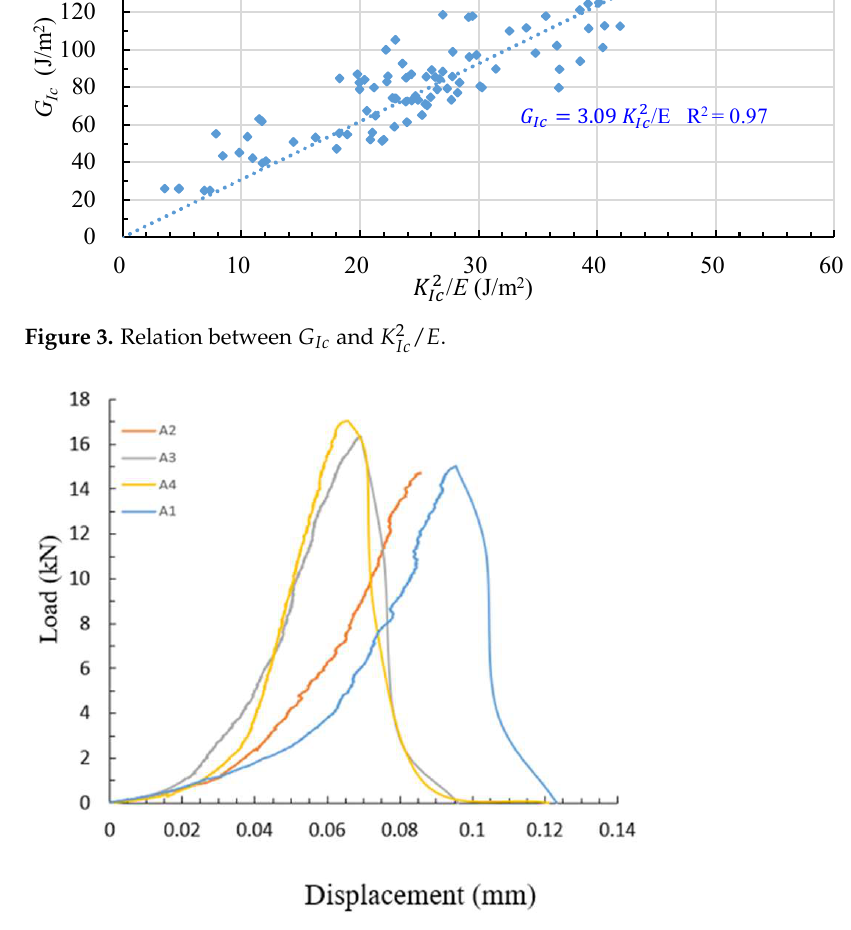
Figure 4. Load–displacement curve of limestone.